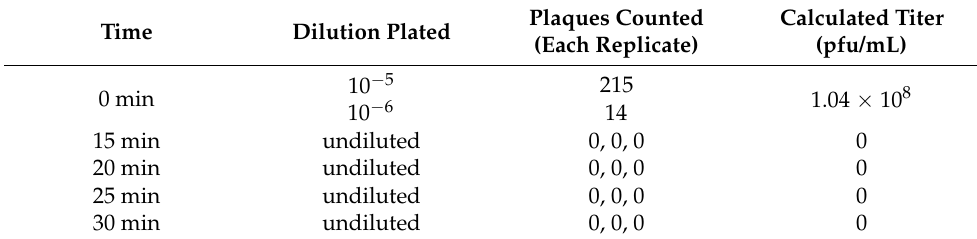
Table 1. Heat inactivation of 1.4 mL in 65 ◦ C Water Bath. Time Dilution